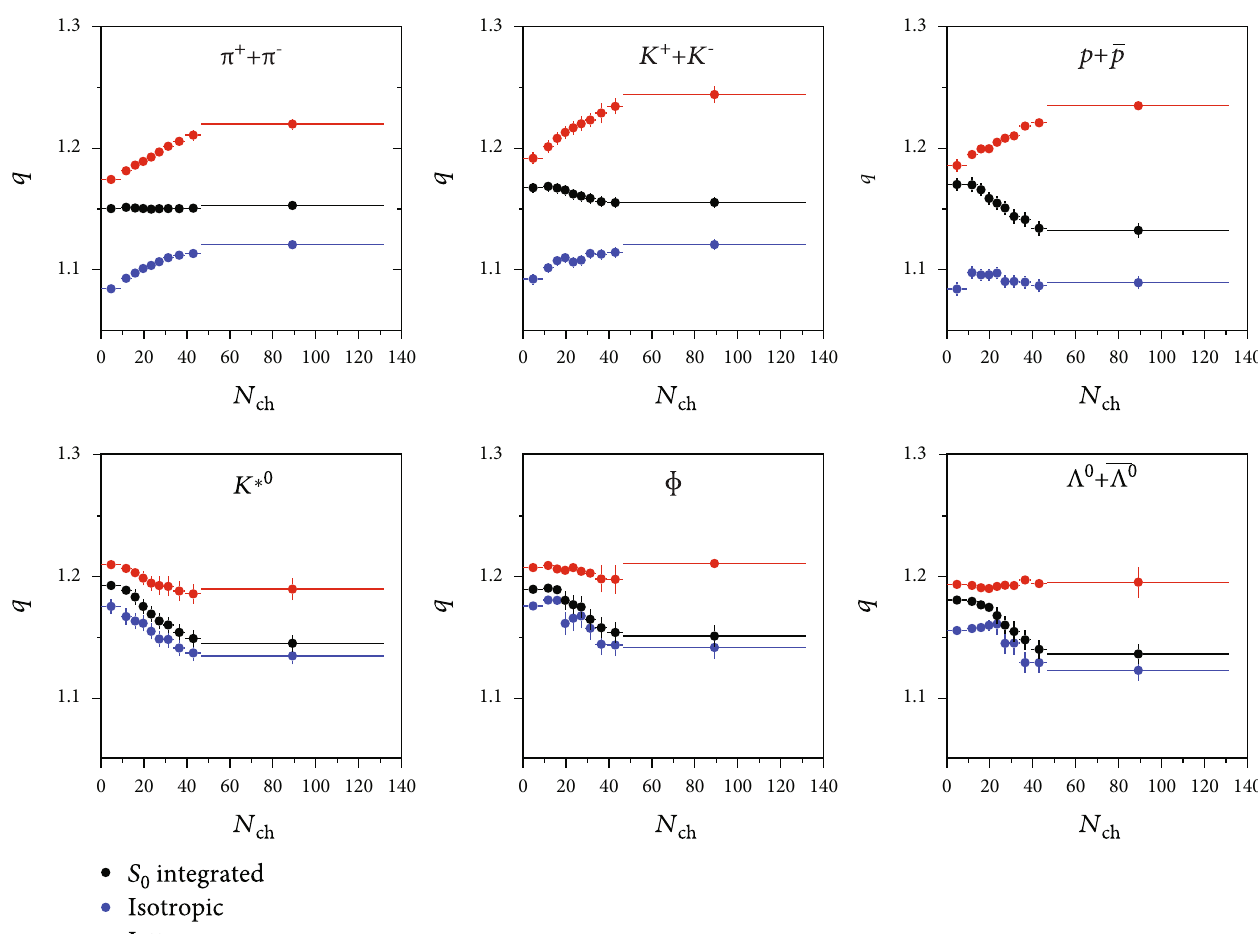
Figure 9: (Color online) Multiplicity dependence of q in di ff erent spherocity classes from the fi tting of Tsallis distribution using Eq.